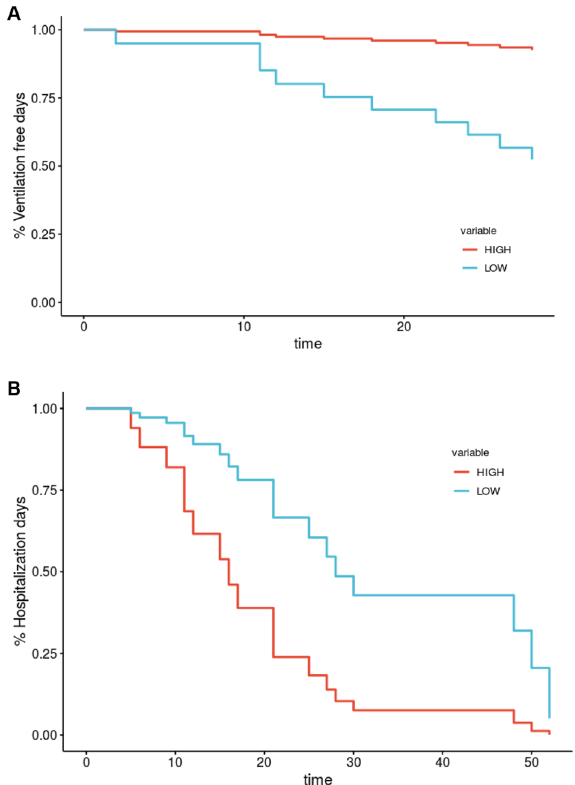
Figure 4. Kaplan–Meier analyses of severity outcomes on COVID-19 patients admitted to the hospital. ( A ) Kaplan–Meier curve for the analysis of the time to mechanical ventilation during a 28-day time window. Patients with a gene expression profile more similar to abatacept (ABS-High) had a lower probability to require mechanical ventilation ( P = 0.047). ( B ) Kaplan–Meier curve for the analysis of hospitalization days. COVID-19 patients with a gene expression profile more different to abatacept (ABS-Low) had a higher probability to spend more days in the hospital ( P =